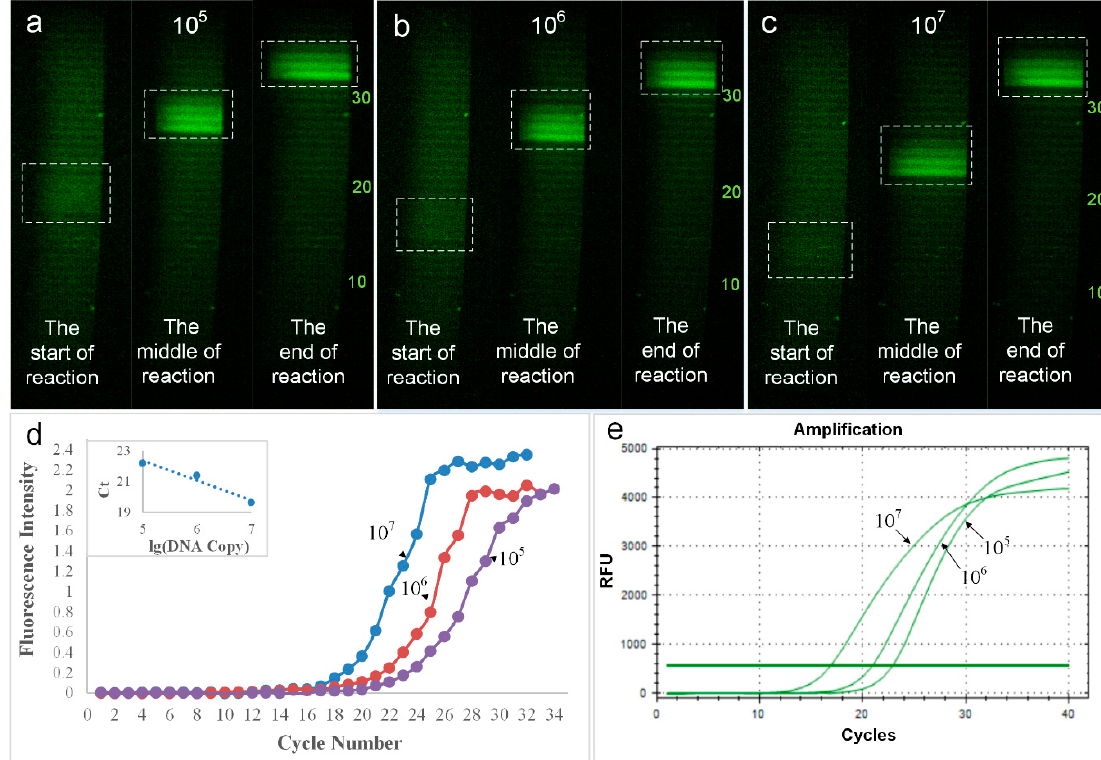
Figure 7. Changes of fluorescence intensity in PCR reaction under different DNA concentration ( a – c ); The amplification curves gained from the fluorescence images of serial diluted DNA molecules of the microdevice ( d ); amplification curves from the commercial real-time PCR amplification system ( e ).